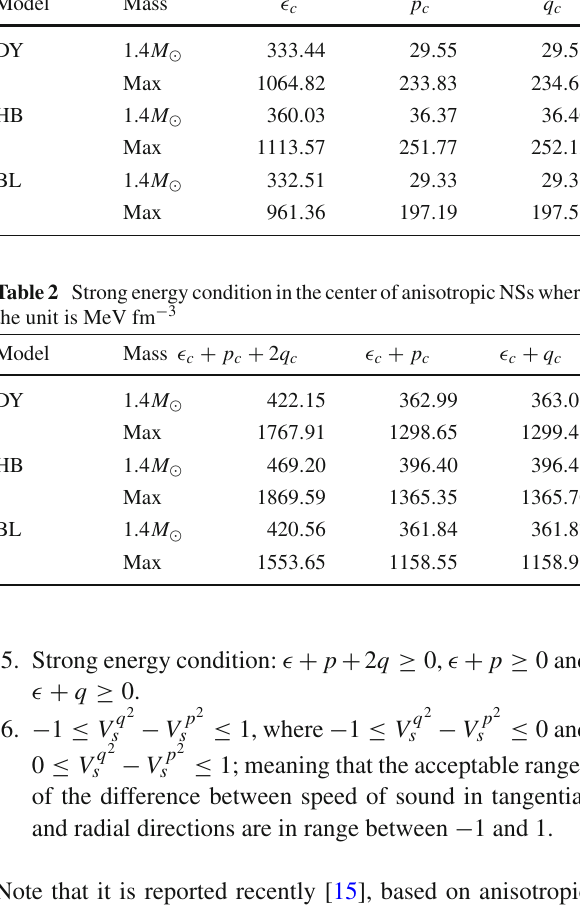
Fig. 5 The gradient of radial pressure of anisotropic models NSs and its isotropic (I) for M = 1 . 4 M (cid:6) and M = M